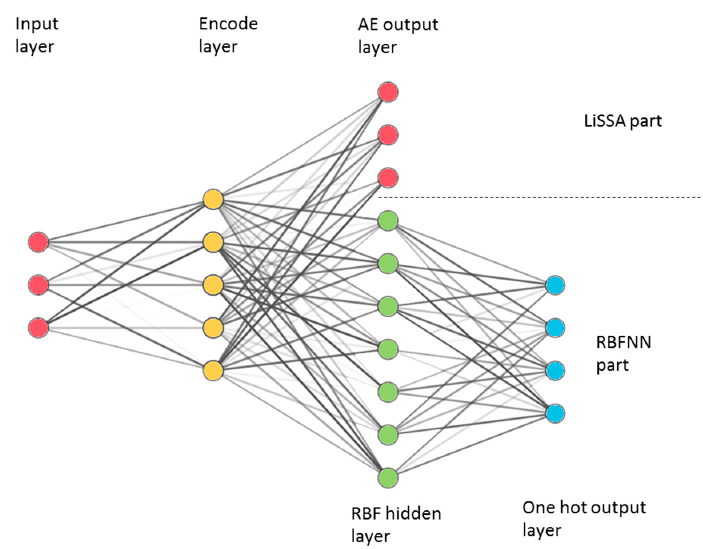
Figure 2. Localized stochastic-sensitive autoencoder-radial basis function (LiSSA-RBF) network structure, consist of the LiSSA part (input layer, encode layer and AE output layer) and the radial basis function neural network (RBFNN) part (Input layer, encode layer, RBF layer and one hot output layer).